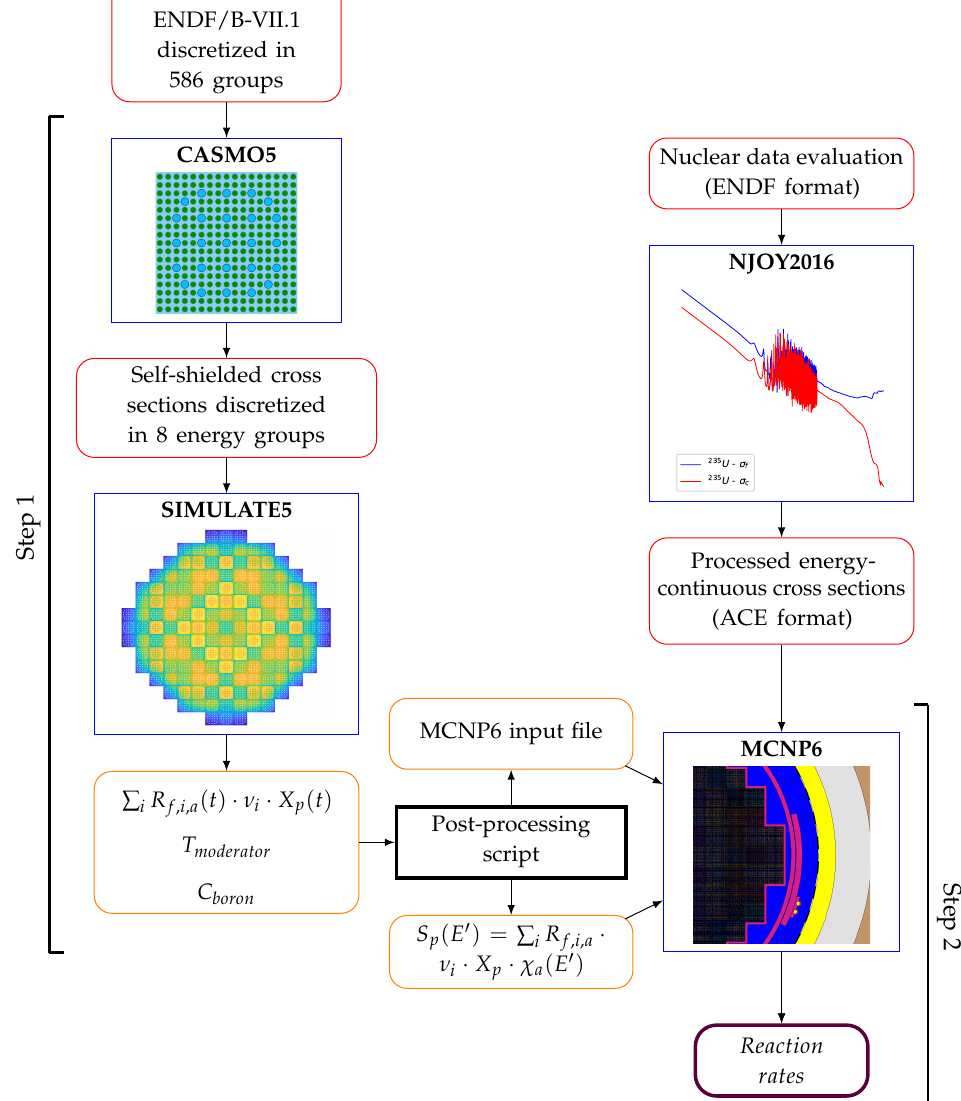
Figure 4. Flowchart of the different codes and steps used in